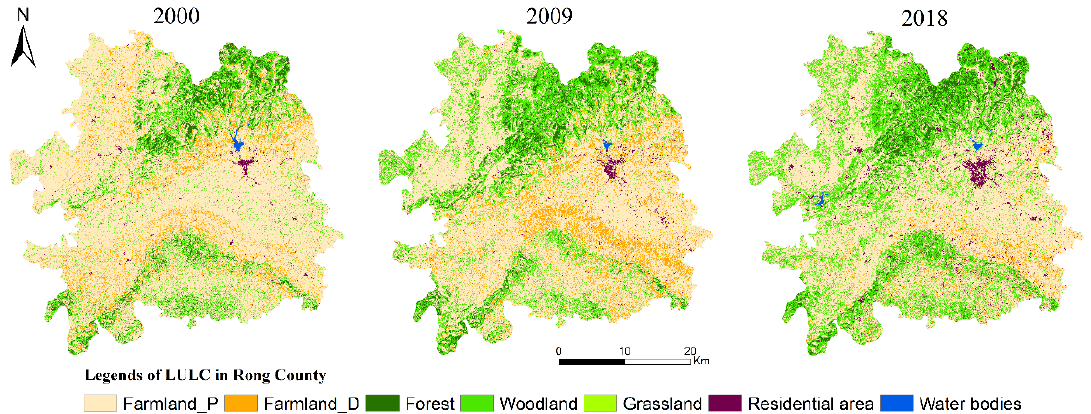
Figure 3. The land use and land cover (LULC) maps of Rong County in 2000, 2009, and 2018.